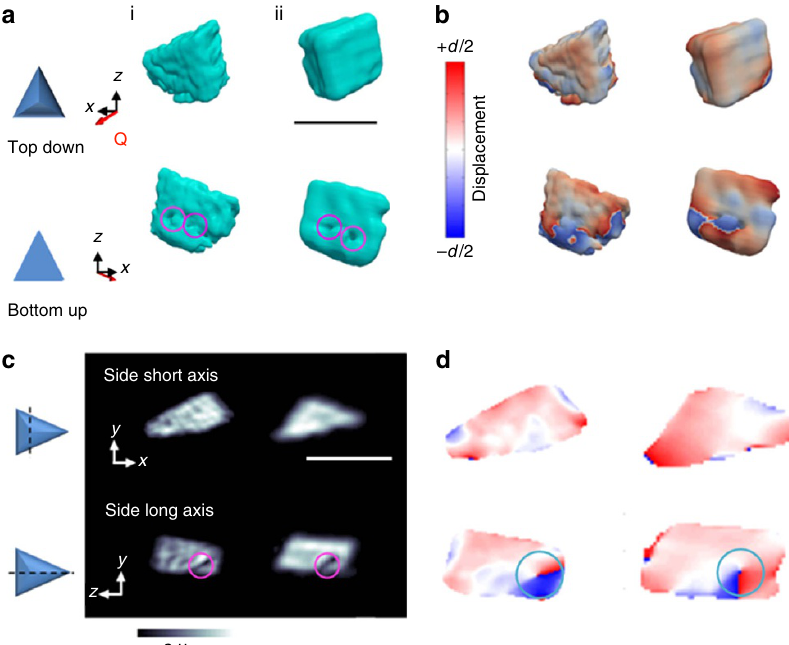
Figure 2 | Bragg coherent diffraction imaging (BCDI) reconstructions. Reconstructions of two different calcite crystals (i) and (ii), which were nucleated on carboxylate-terminated SAMs, are shown. The reconstructed crystal shapes from BCDI amplitude measurements are shown in a , where these are viewed from the directions indicated. The surface cusps, which appear on the bases of both crystals, are circled. ( b ) The projected displacements ( (cid:2) d /2 blue lattice dilation and þ d /2 red lattice contraction) of the crystals. ( c ) Sections through the electron density maps and ( d ) sections cut through the displacement maps, where these made through the centres of the crystals, normal to the substrate. The surface cusps (magenta circle) and areas of spiral displacement (cyan circle) are highlighted. The beam direction is along the z axis, with the y axis vertical, while the sample/substrate is located at a set scattering angle towards the beam direction ( z ) with Q the scattering vector. Scale bar, 1.8 m